Question: Looking at the figure, what chart type is it?
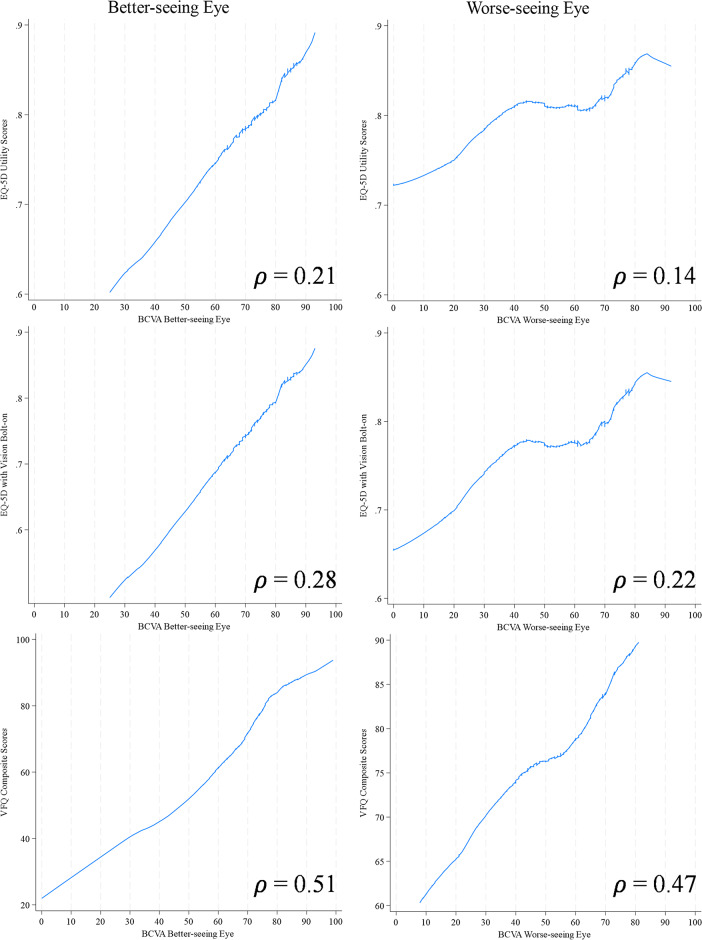
Answer: scatter